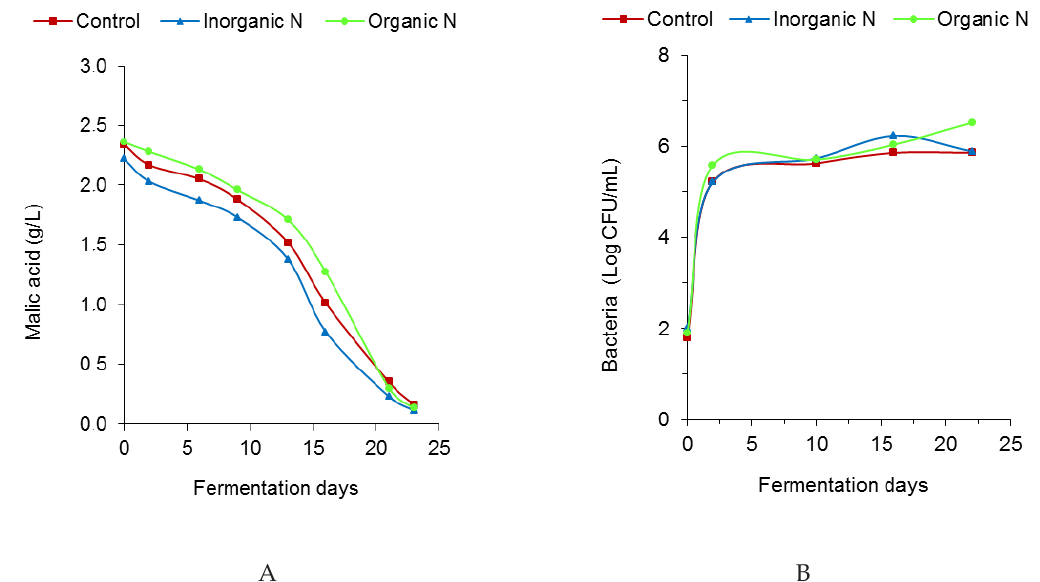
Figure 2. Malic acid degradation ( A ) and lactic acid bacteria (LAB) count ( B ) during the malolactic fermentation (MLF) carried out from wines made with different nitrogen additions.